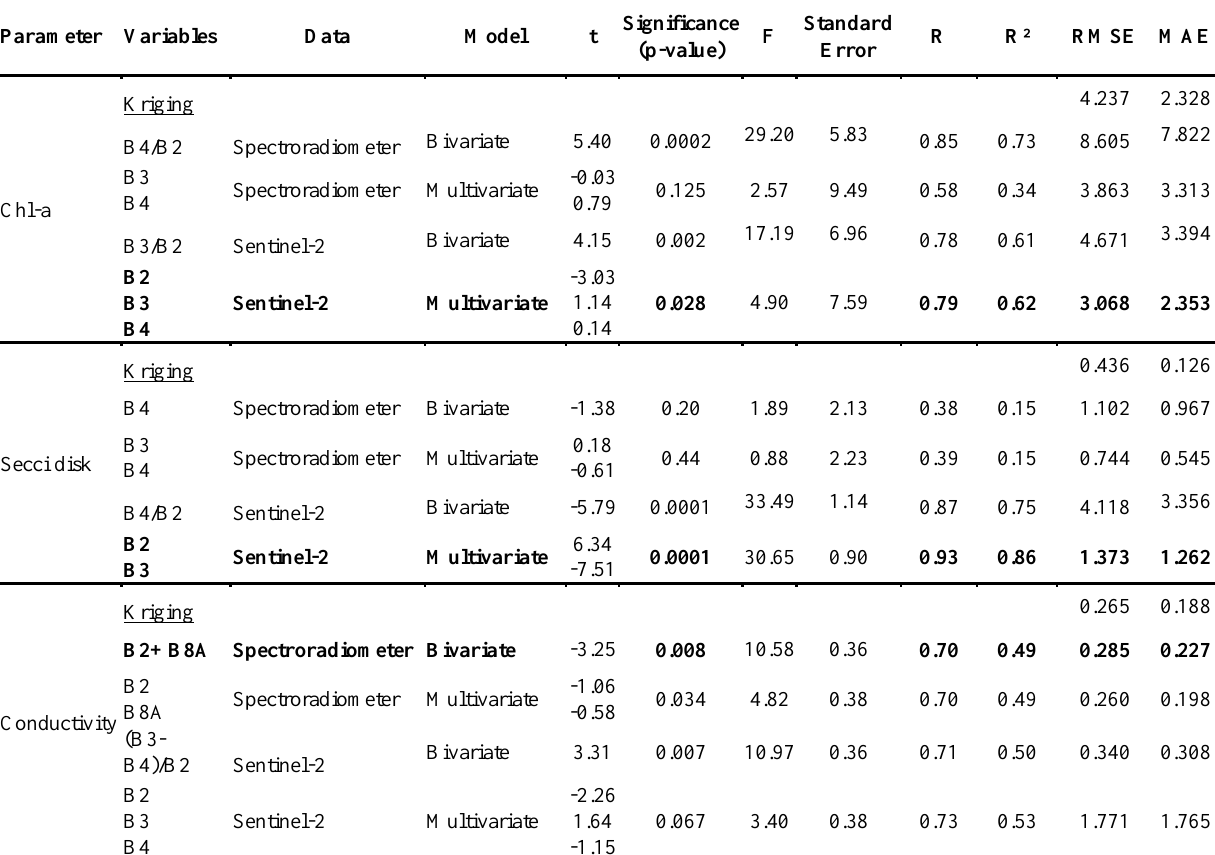
Table 1. The bivariate and multivariate regression models used for three water quality parameters on two different measurement datasets (the best predictive models selected are marked in